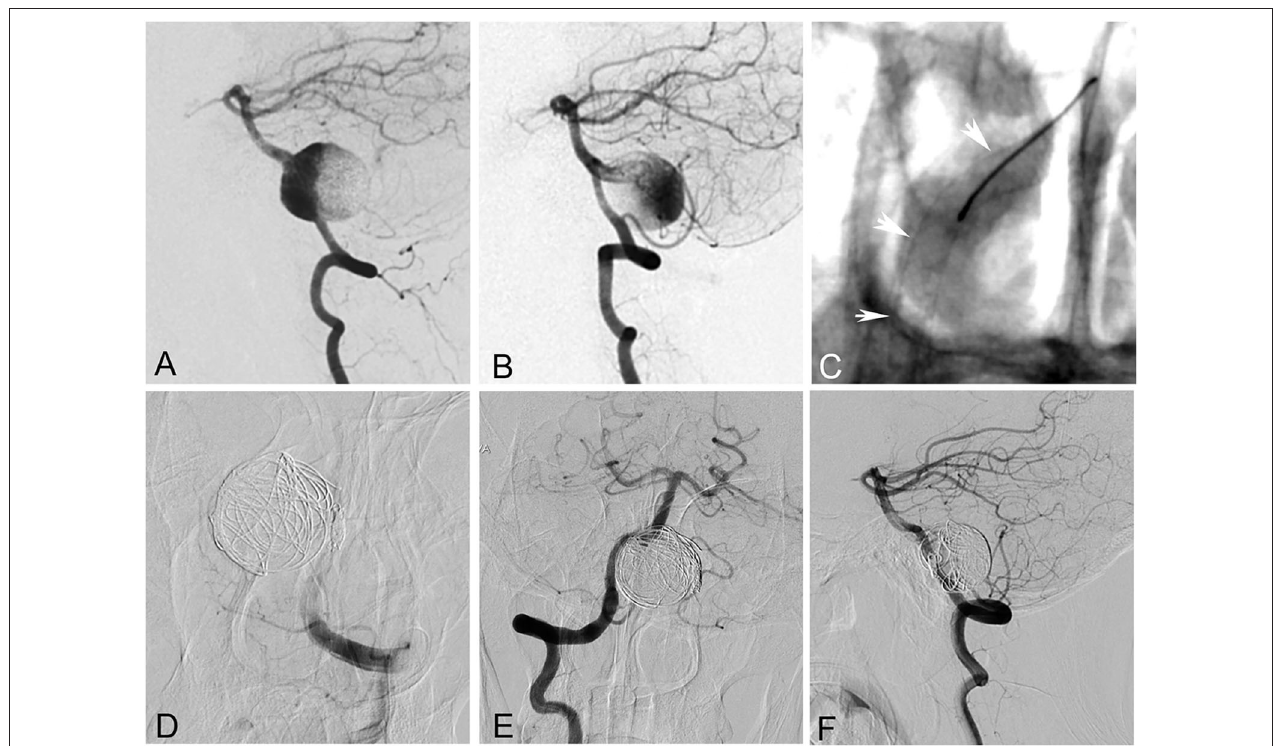
FIGURE 3 | A 55-year-old woman with a giant saccular aneurysm at the vertebrobasilar junction. (A,B) Bilateral vertebral angiogram showed the aneurysm. (C) The right vertebral and basilar arteries were reconstructed with a pipeline embolization device. (D) The left vertebral artery and the aneurysm were occluded with coils. (E,F) Right vertebral angiogram showed complete occlusion of the aneurysm after the procedure. However, the patient died of brainstem function failure 3h later after worsening of mass effect.